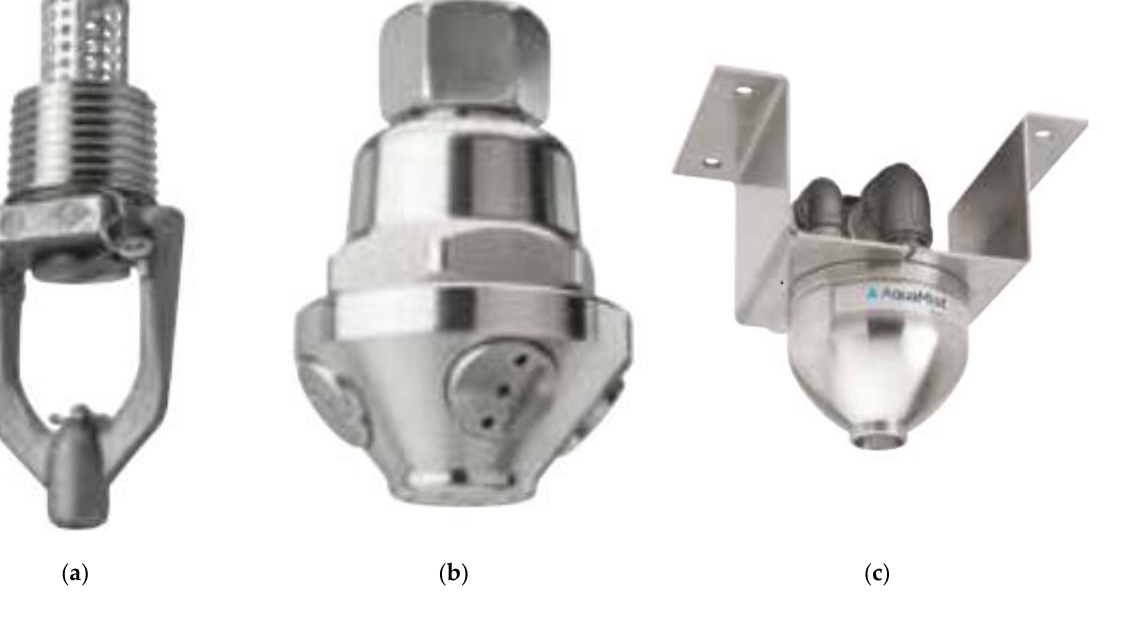
Figure 2. Types of nozzles used to create water mist in water mist systems. ( a ) Impingement noz- zle [21]; ( b ) Pressure jet nozzle [21]; ( c ) Twin-fluid water nozzle [21].